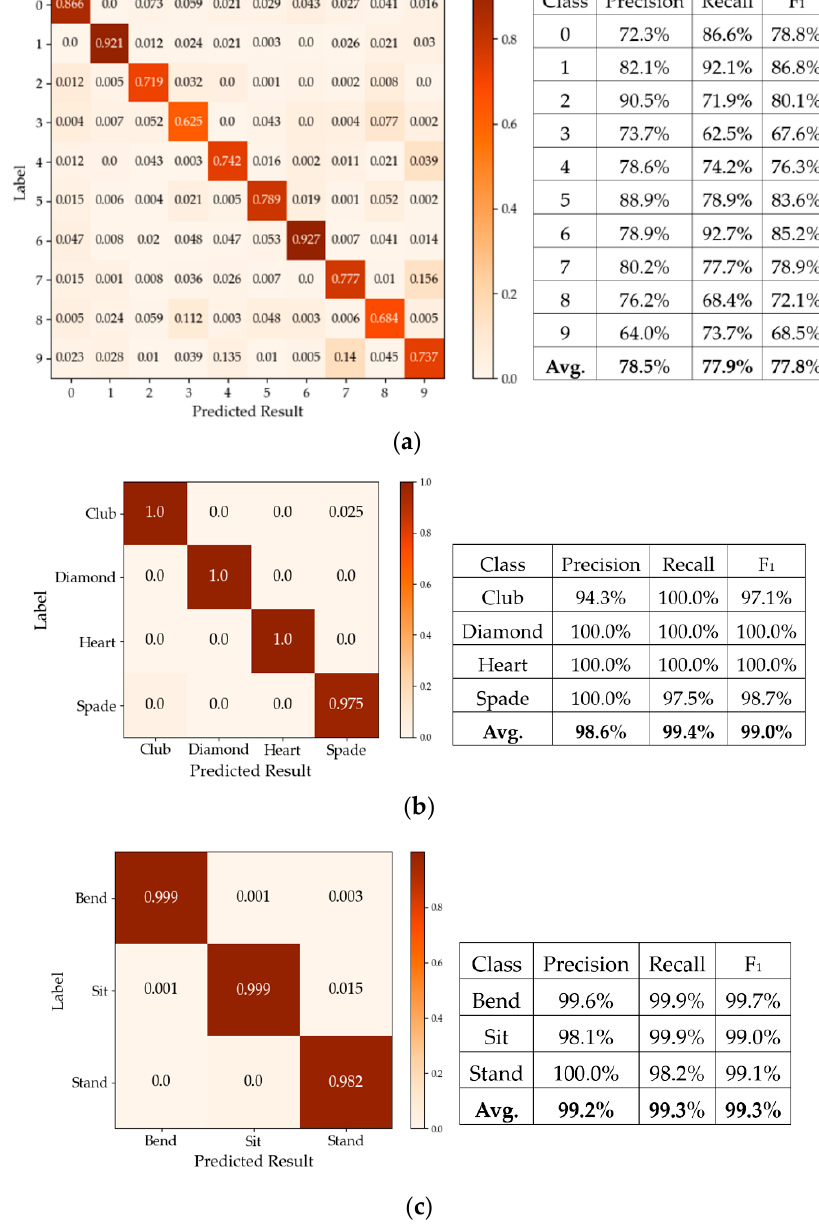
Table 1. Hyperparameter settings for different DVS datasets [30].